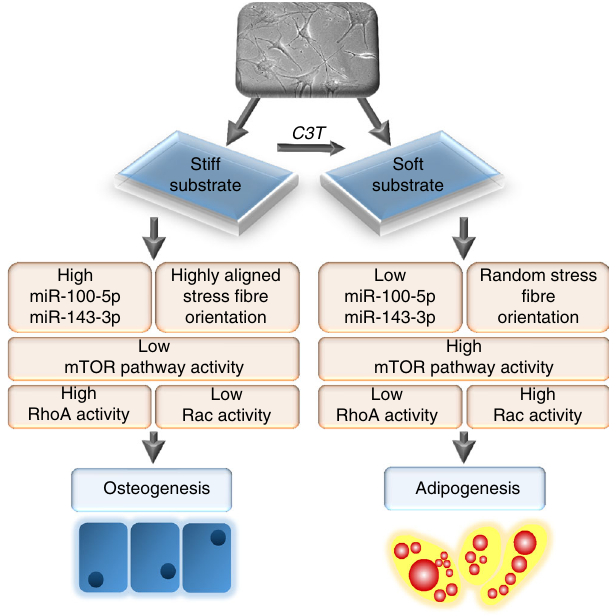
Fig. 7 Proposed model of differential mTOR regulation and hMSC differentiation in response to miRNA signalling and substrate